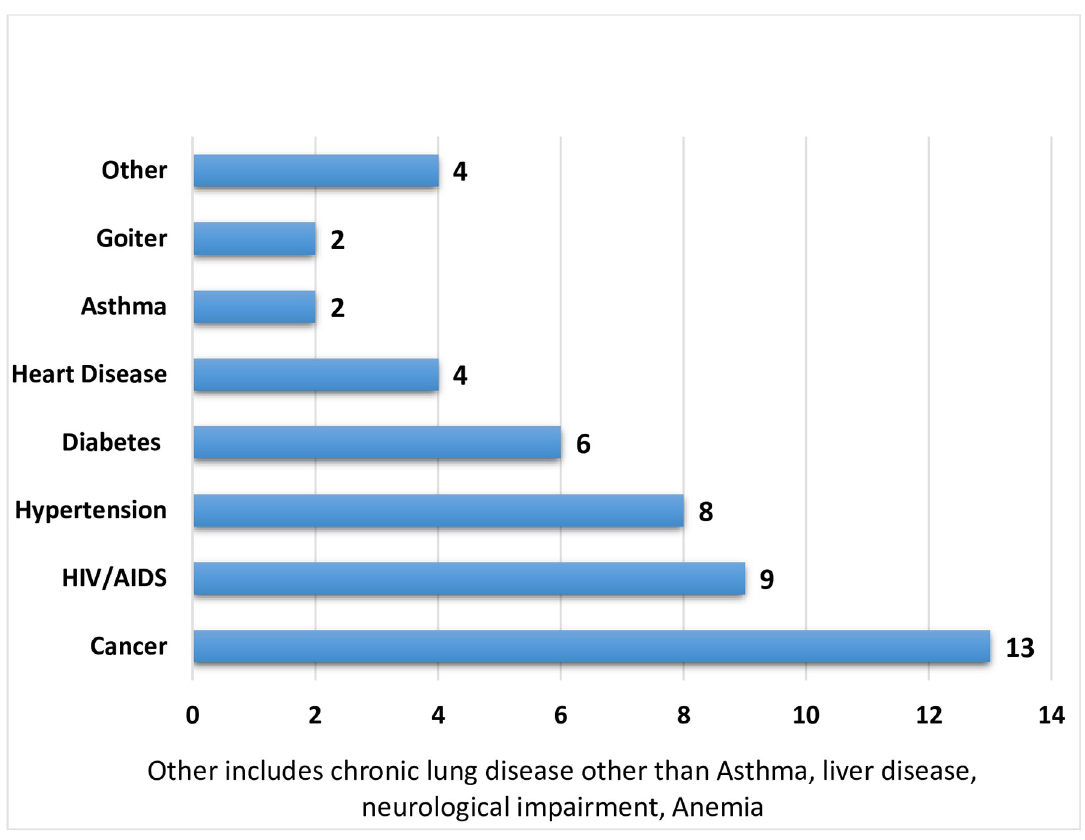
Fig 2. Number of study participants with preexisting medical conditions, Eka Kotebe General Hospital, COVID-19 Isolation and Treatment Center, 2020.